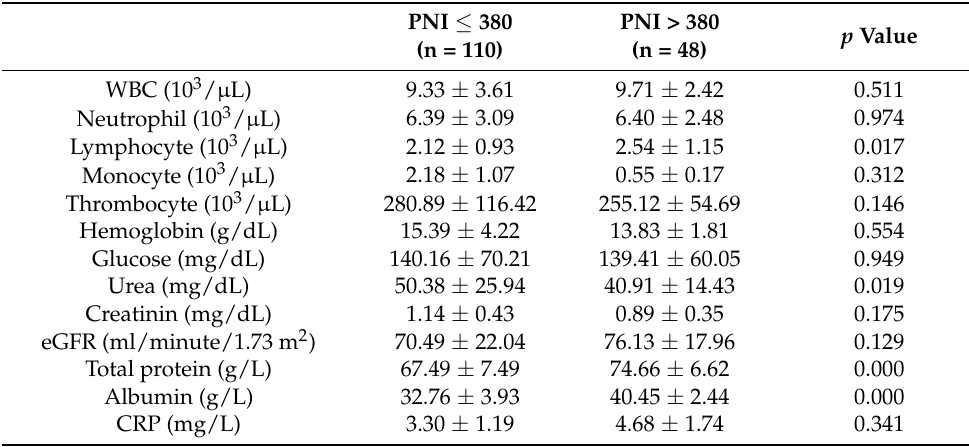
Table 2. Laboratory parameters of